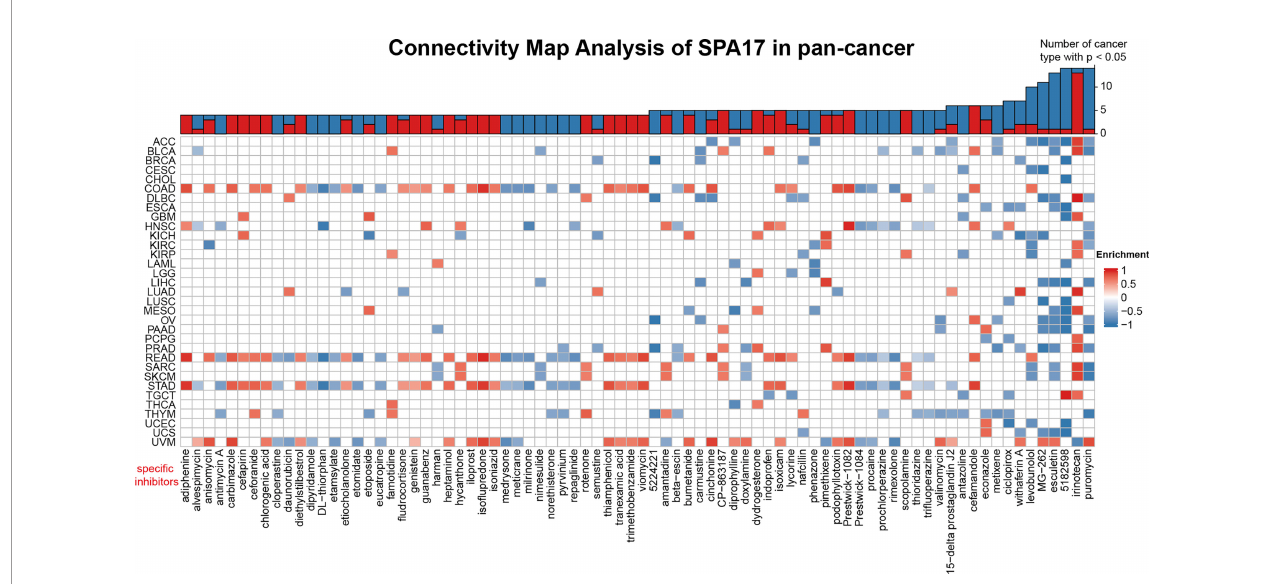
FIGURE 6 | Heatmap representing the rich fraction (positive in blue, negative in red) of each drug in the CMap database of each cancer. Components or drugs are ranked in descending number of enriched cancers from right to